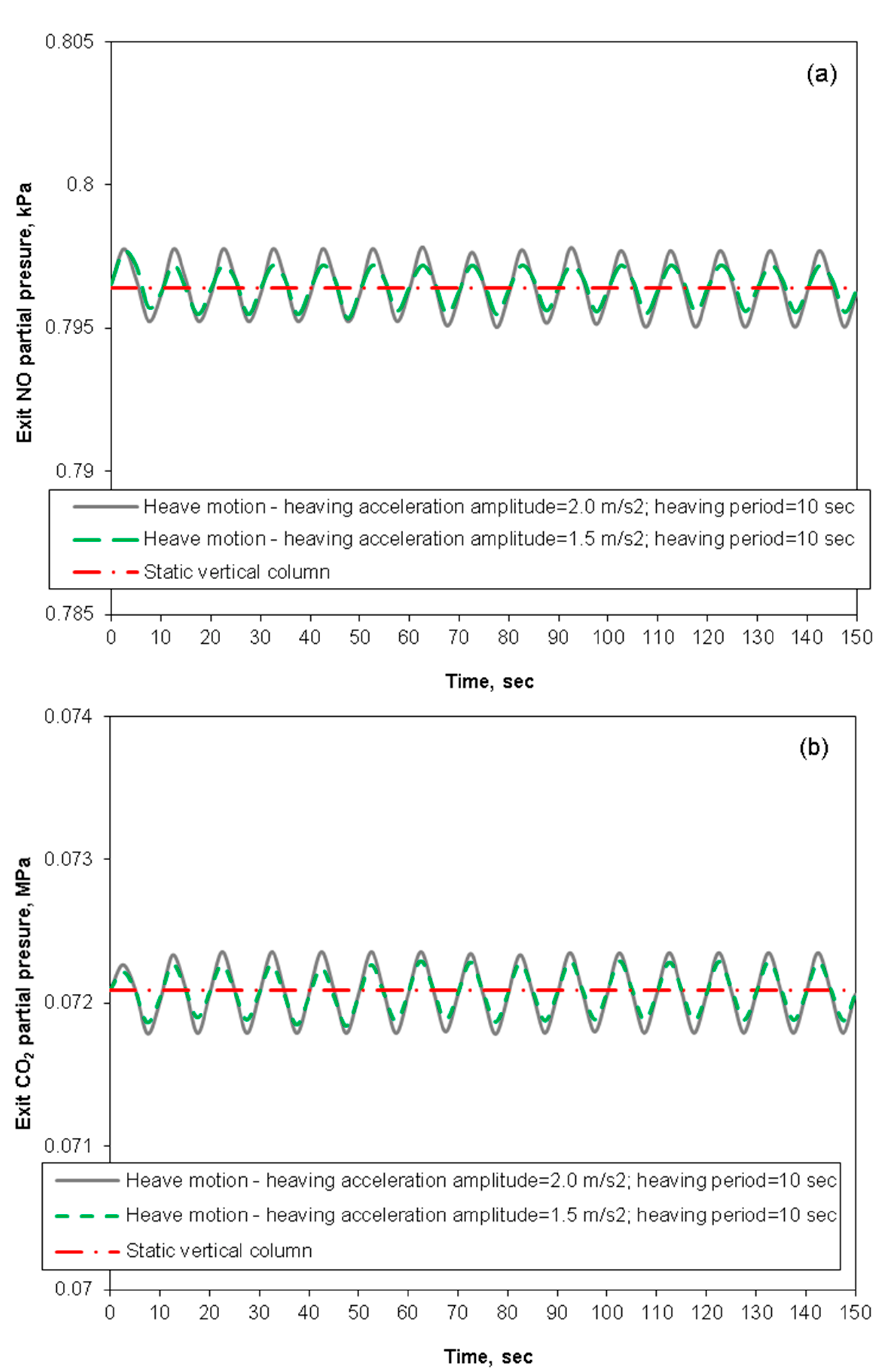
Figure 18. Time-dependent exit NO ( a ) and CO 2 ( b ) partial pressure in a seawater scrubber under heaving motion conditions at di ff erent heaving acceleration amplitudes (Packed-bed column with Raschig super-Rings; H = 5 m; Pressure = 1.5 MPa).